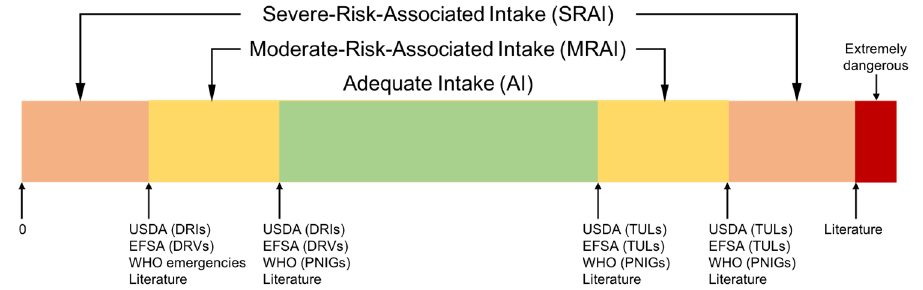
Figure 1. The three proposed intake categories: adequate intake (AI), moderate- and severe-risk- associated intakes (MRAI and SRAI). Threshold values were found in USDA DRIs and TULs [29,30], EFSA DRVs [31,32] and TULs [33], WHO PNIGs [34,35] and emergency management handbooks [23,36], and in other literature (see Table S2 ‘Human Nutritional Needs’ in Supplementary Infor- mation).